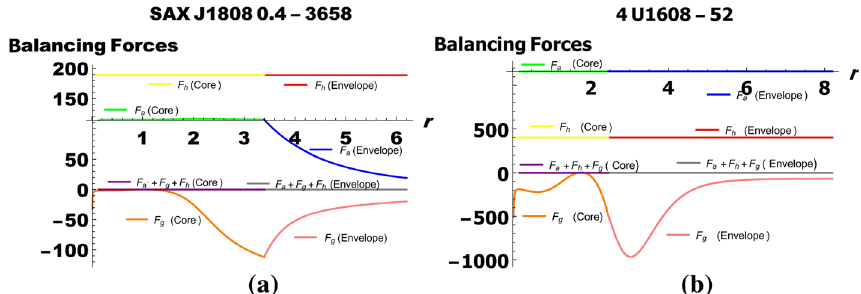
Fig. 12 Variation of balancing forces with radial coordinate